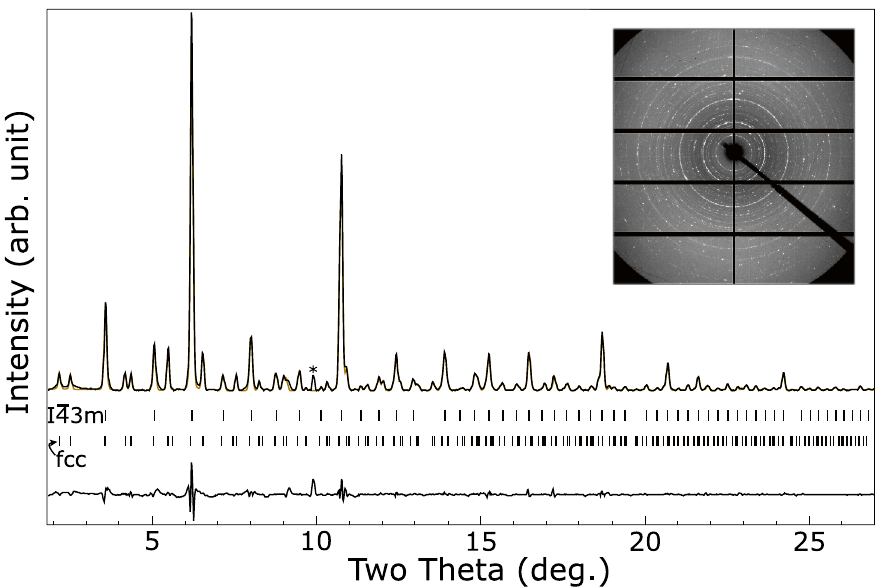
Figure 8. Integrated diffraction pattern of the lithium–palladium–hydrogen intermetallics at ambient temperature and 0.39 GPa (black), with LeBail fit to the low-pressure fcc phase ( a = 19.324 Å) and the high- ¯ 43 m pressure I phase ( a = 9.597 Å) (orange) and residual on same scale (lower black line). Allowed peak positions for each phase are indicated by ticks. The unfitted peak marked with an asterisk is the (cid:31) 110 (cid:30) reflection from bcc -lithium. Inset: Unintegrated diffraction pattern.